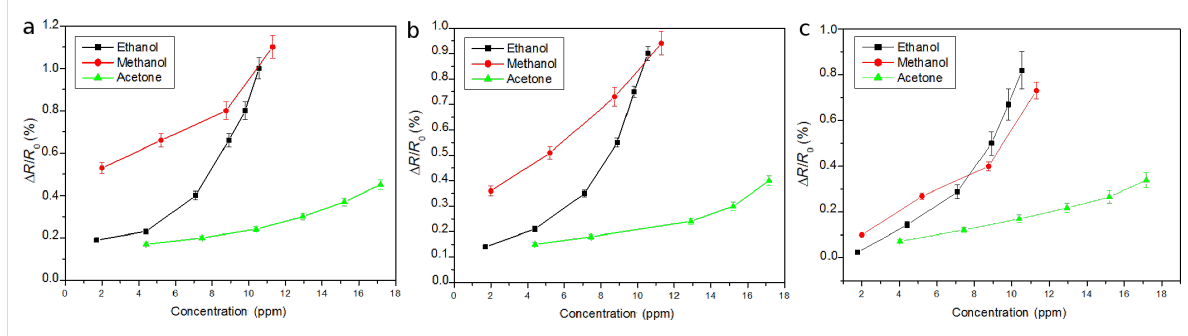
Figure 5: (a) Calibration curves of Pt–MWCNT sensors to vapours. (b) Calibration curves of Pd–MWCNT sensors to vapours. (c) Calibration curves for oxygen-plasma-treated, bare MWCNT sensors to vapours.